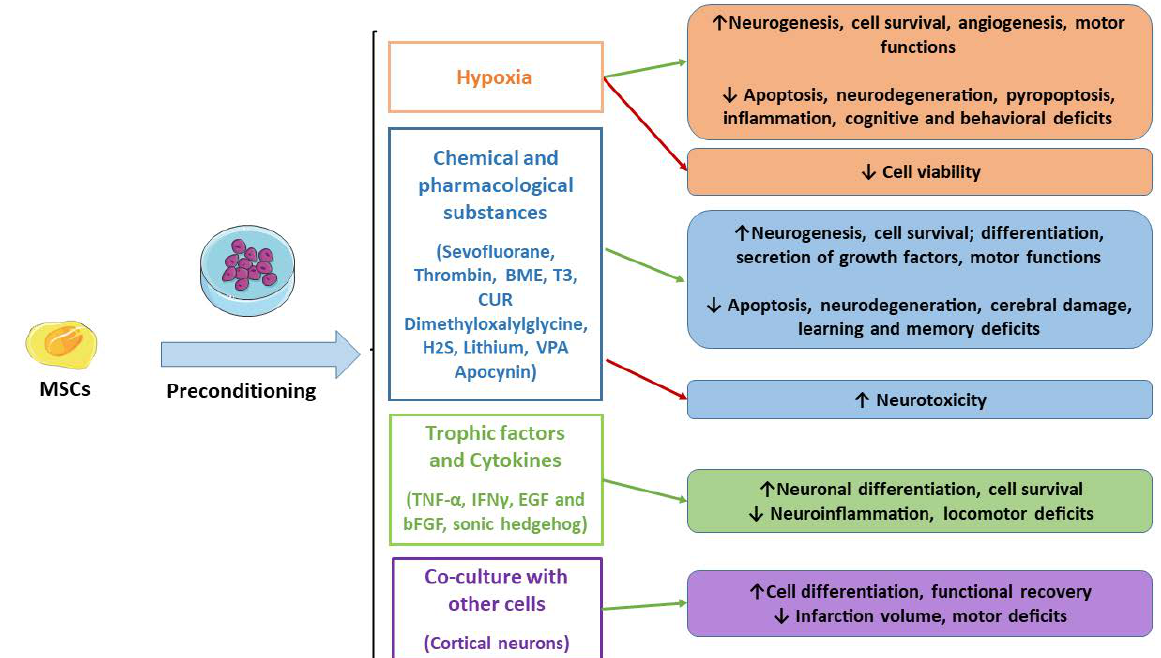
Figure 1. Main MSCs’ preconditioning methods. Green arrows indicate the advantages, while red arrows indicate disadvantages. MSCs: mesenchymal stromal cells; BME: β -mercaptoethanol; T3: triiodothyronine; CUR: